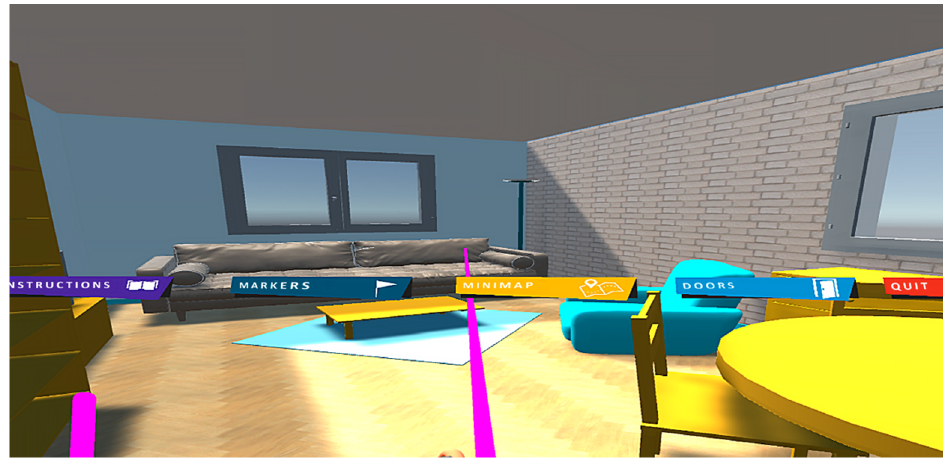
Figure 6. MainUI interface with six floating buttons used to open the main interfaces of the application: IntructionsUI, MarkersUI, MinimapUI and DoorsUI, and to exit the application using the Quit button.